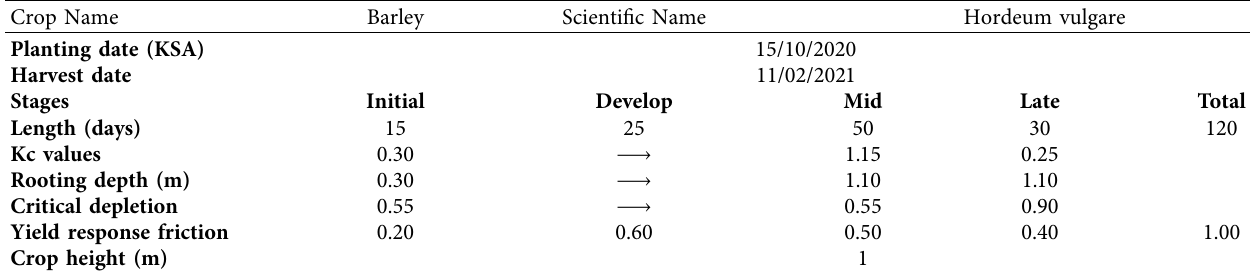
Table 11: Barley crop data at various stages.